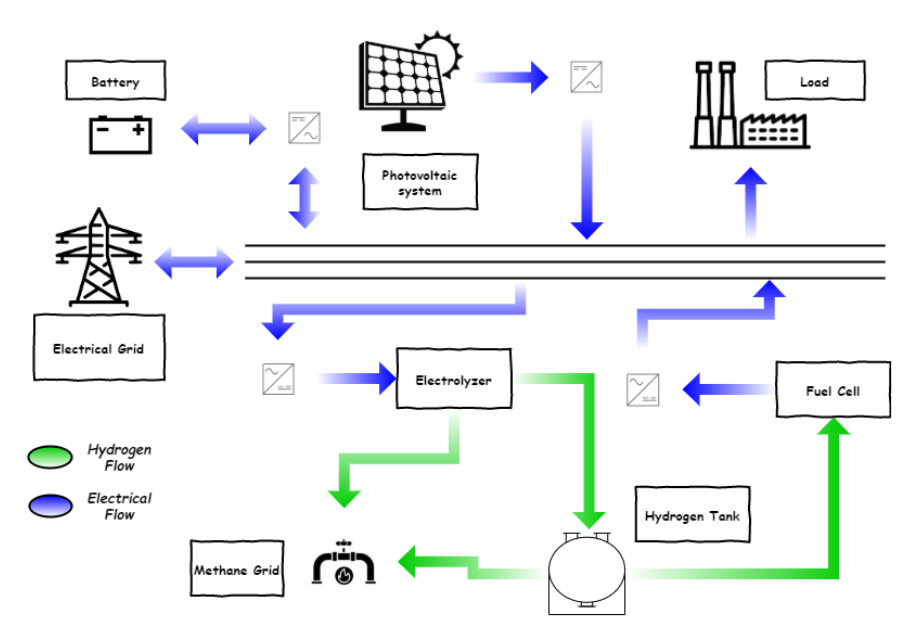
Figure 1. Schematic of the HES plant